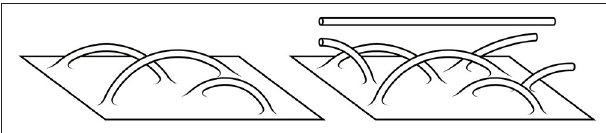
FIGURE 6 | The effective action considered as an amplitudes (Left) and an amplitude including semiwormholes (Right)